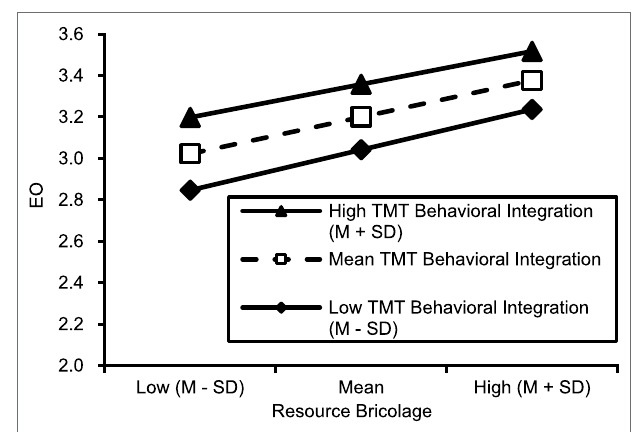
FIGURE 2 | TMT behavioral integration’s moderating